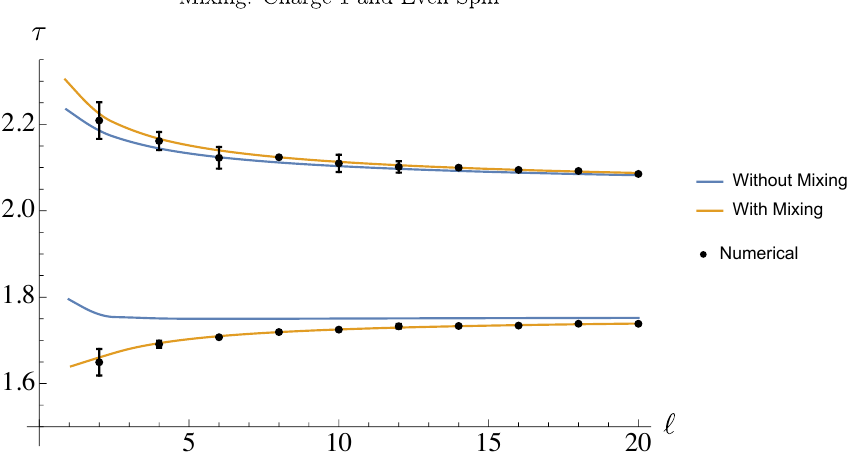
Figure 24 . A comparison between using or not using the twist Hamiltonian for the leading trajec- tories in the charge 1 even-spin sector.